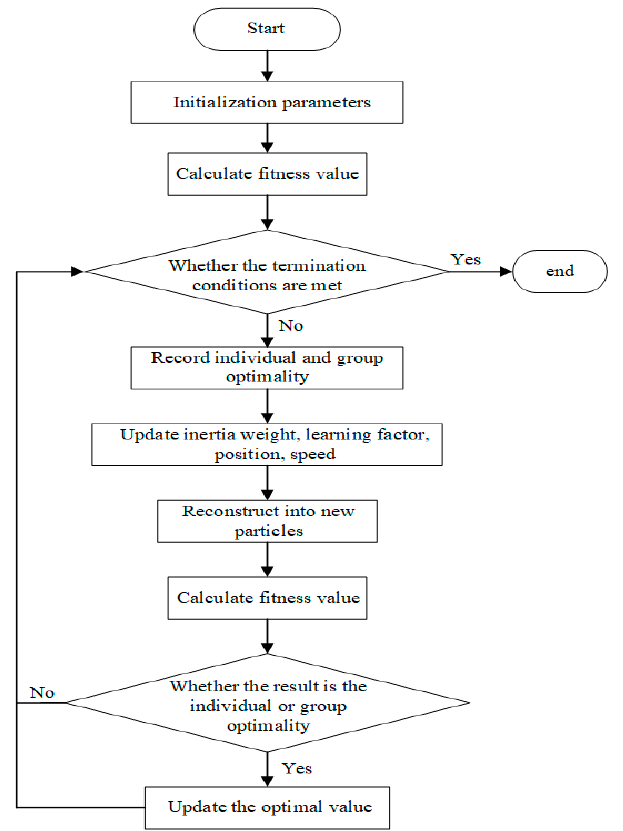
Figure 1. The flow chart of the APA-PSO-VMD method.